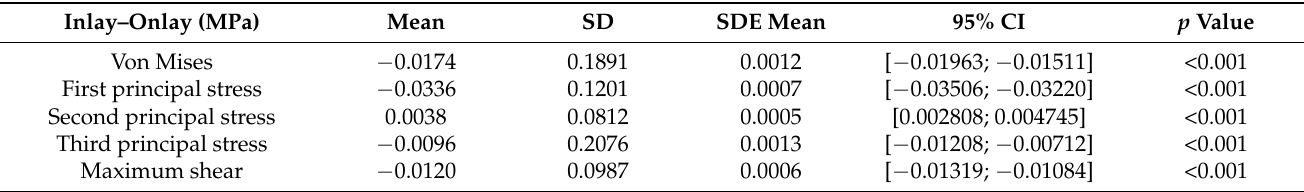
Table 10. Paired differences in the results between pairs of models. Statistical analysis with a paired samples t -test, with confidence intervals for the difference for the “bed”